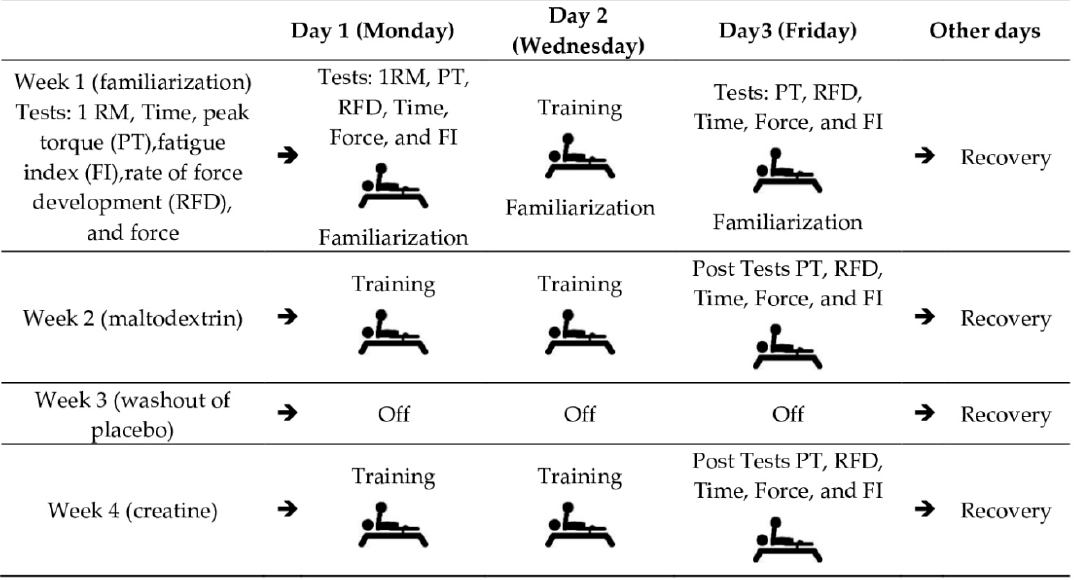
Figure 1. Experimental design—weekly schedule of tests and washout. 1RM: 1 repetition maximum. Training carried out three times a week, and the remaining days weredestined to rest [2].